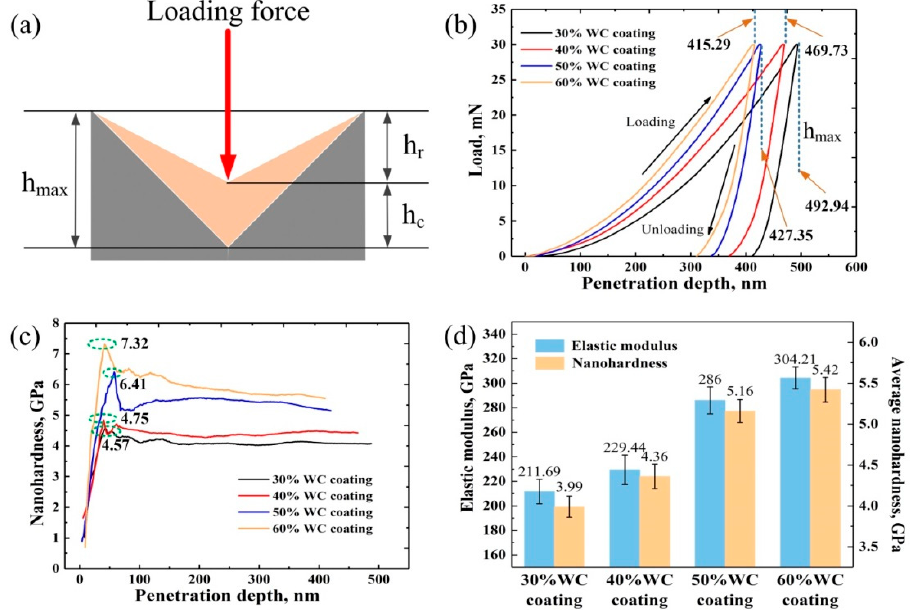
Figure 6. ( a ) The principle of the nanoindentation test, ( b ) nanoindentation p–h curves of 30–60% WC coatings, ( c ) the variations of nanohardness against penetration depth, and ( d ) elastic modulus and nanohardness.